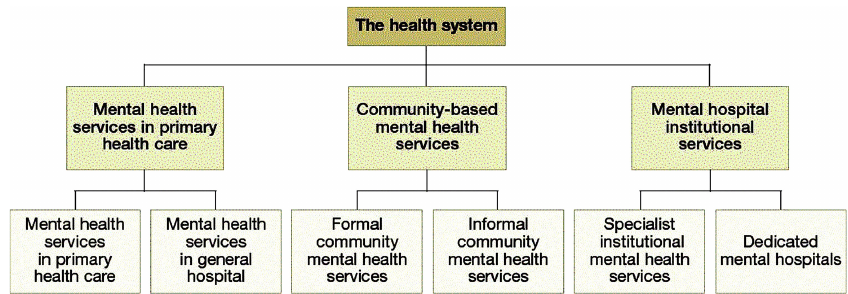
Figure 1. Different types